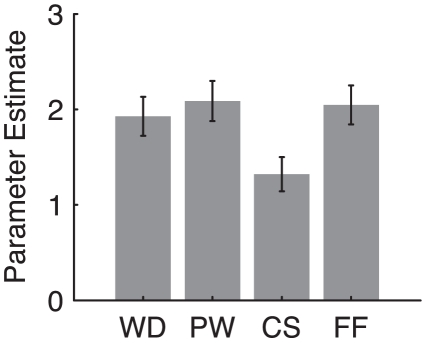
The mean response magnitude in the VWFA.Error bars represent standard error across all participants.